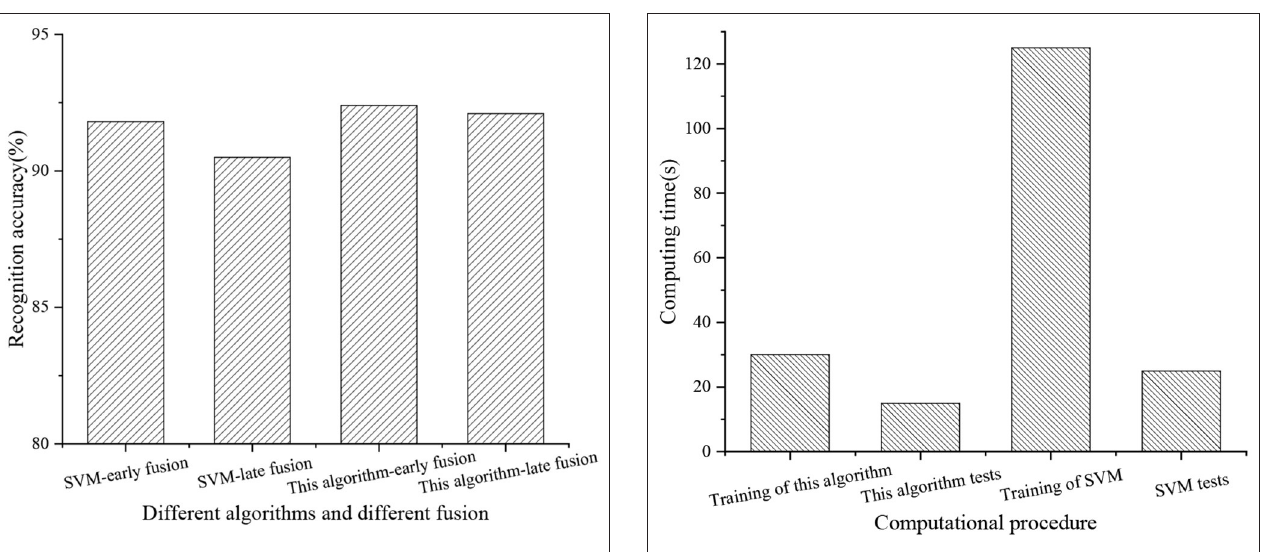
FIGURE 14 | Comparison of time efficiency of different